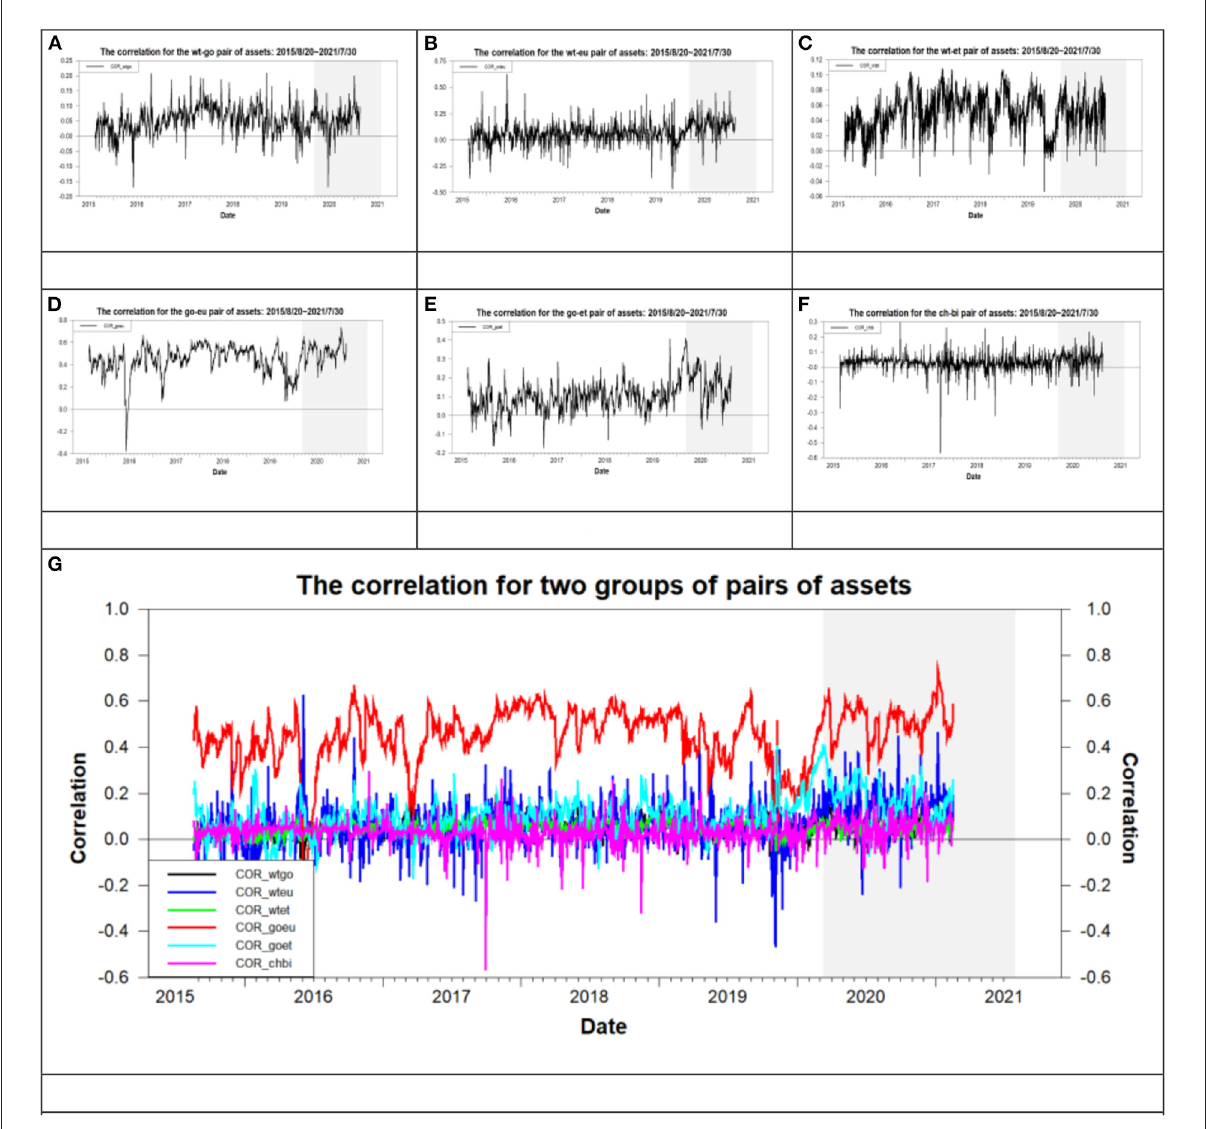
FIGURE5 The time-varying correlation for six pairs of assets. (A) wt-go, (B) wt-eu, (C) wt-et, (D) go-eu, (E) go-et, (F) ch-bi, and (G) all six pairs of